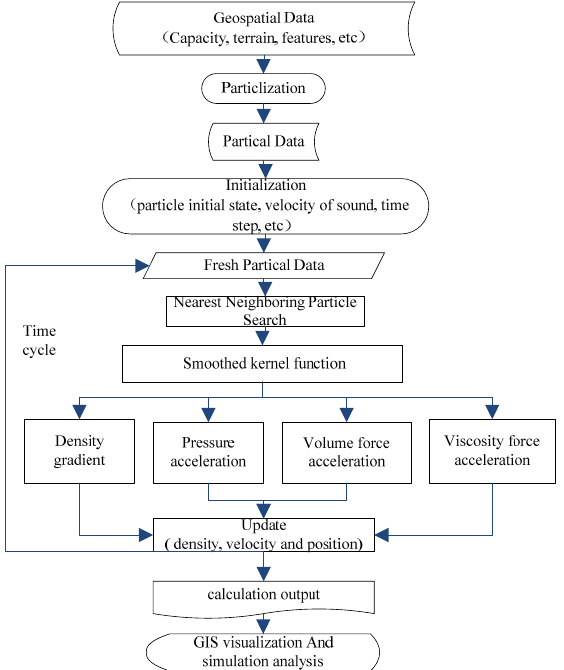
Figure 2. The flow of simulation calculation based on